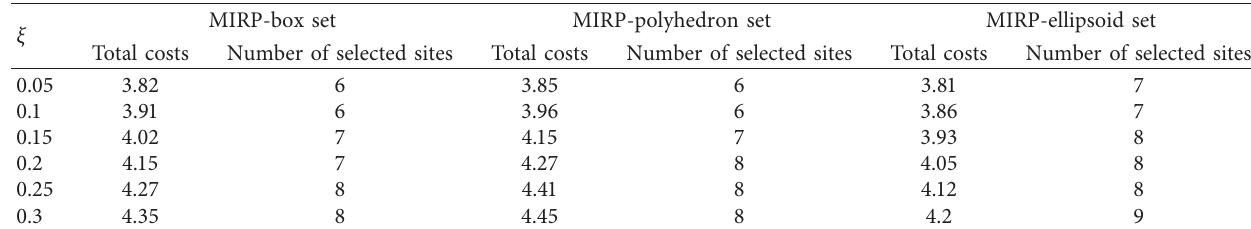
Table 11: Impact of demand disturbance ratio on the